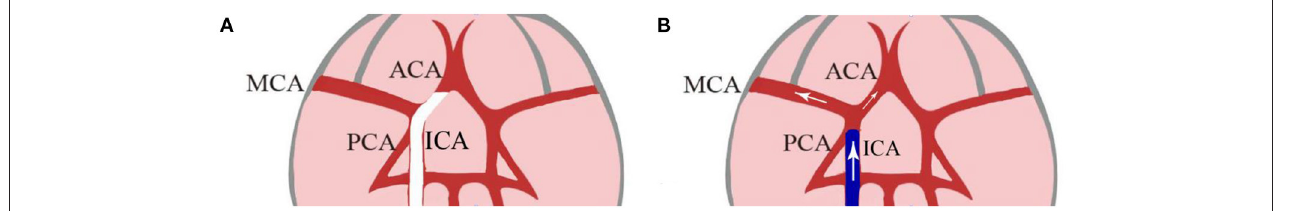
FIGURE 1 | A hollow catheter lodges in the narrow proximal ACA and blocks the MCA at its origin (A) . After 2h of occlusion, saline was flushed into the junction of the MCA and ACA as the hollow filament is withdrawn 1 to 2mm from the origin of MCA (B) . [Modified from Ding et al. ( 26)]. ACA, anterior cerebral artery; MCA, middle cerebral artery; ECA, external carotid artery; ICA, internal carotid